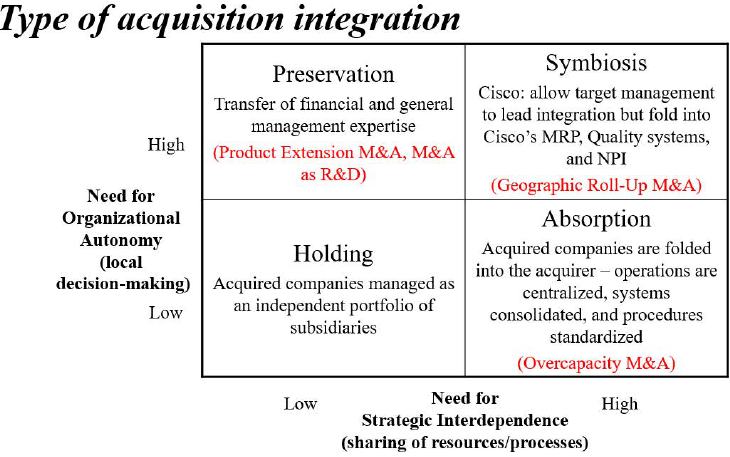
Fig. 1 Financial